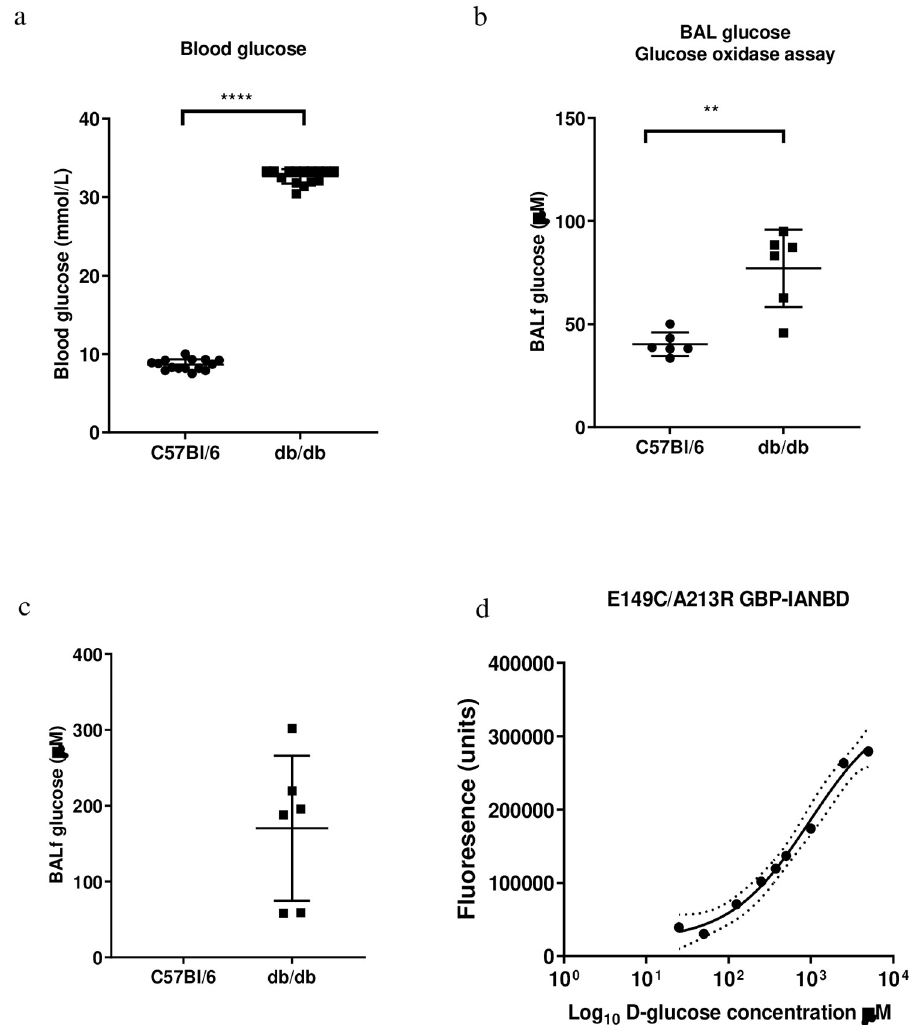
Fig 7. a. Blood glucose concentration (mmol/L), Bronchoalveolar lavage (BAL) glucose concentration measured by b. glucose oxidase assay and c. E149C/A213R GBP-IANBD for C57Bl/6 and db/db mice used in study. Data are shown as mean ± SD. Significantly different �� p < 0.01, ���� p < 0.0001. d. E149C/A213R GBP-IANBD fluorescence/D-glucose concentration curve. Data were fitted with a curve using Graphpad